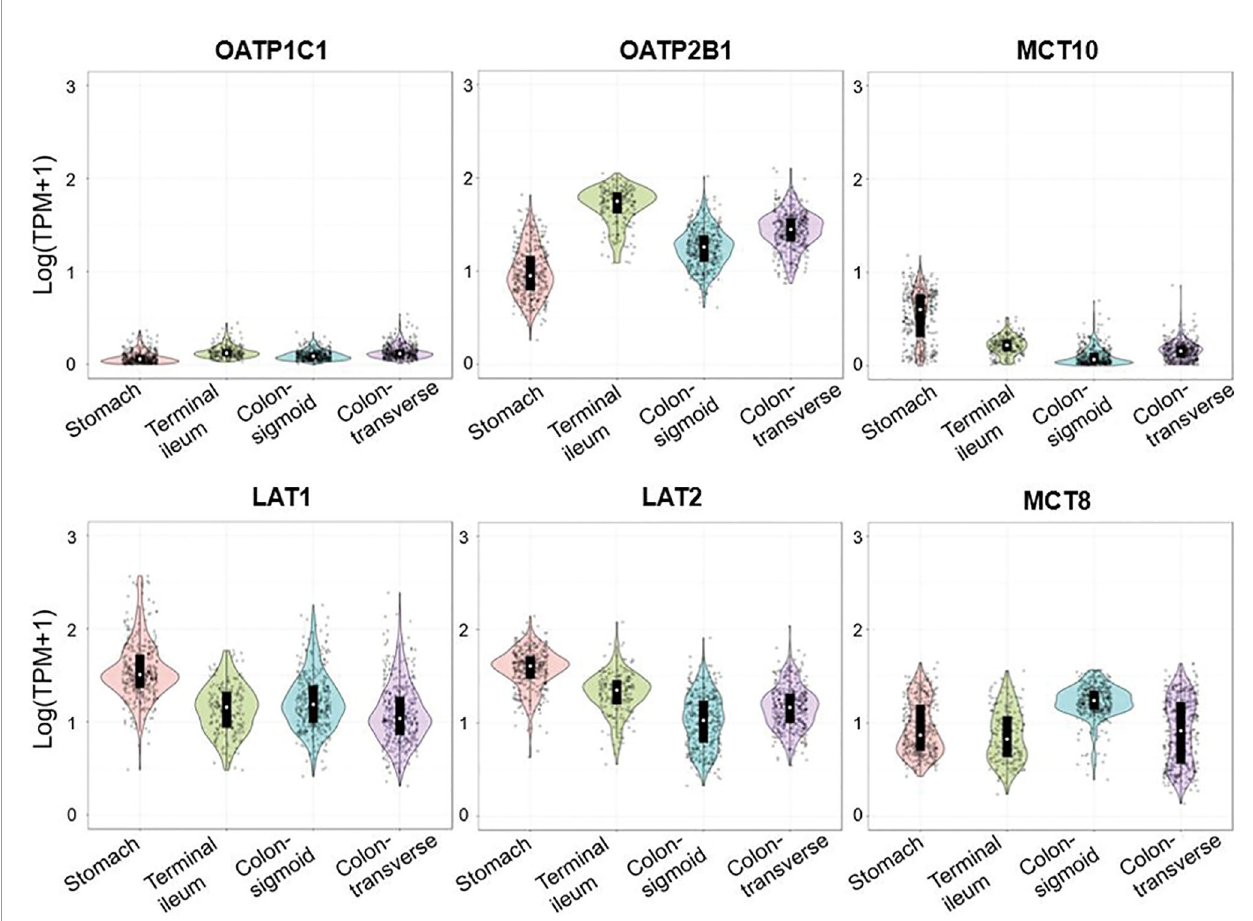
FIGURE 5 | Expression of SLCO1C1 (OATP1C1), SLCO2B1 (OATP2B1), SLC16A10 (MCT10), SLC7A5 (LAT1), SLC7A8 (LAT2), and SLC16A2 (MCT8) in gastrointestinal tract. Violin plots were used to express the TPM data of transporters in each tissue. The colors indicate the different tissues. TPM, transcripts per